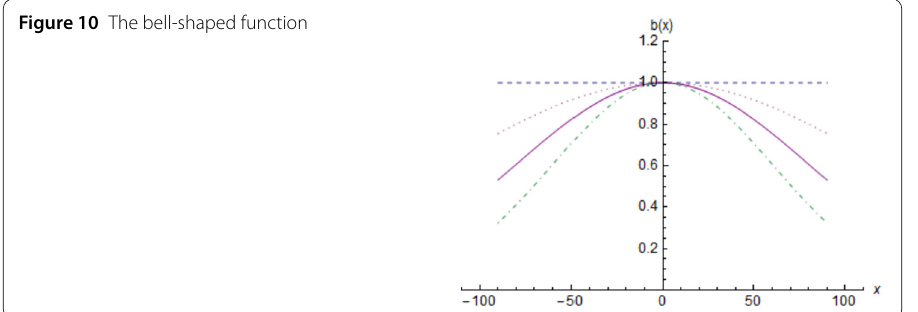
Figure 10 The bell-shaped